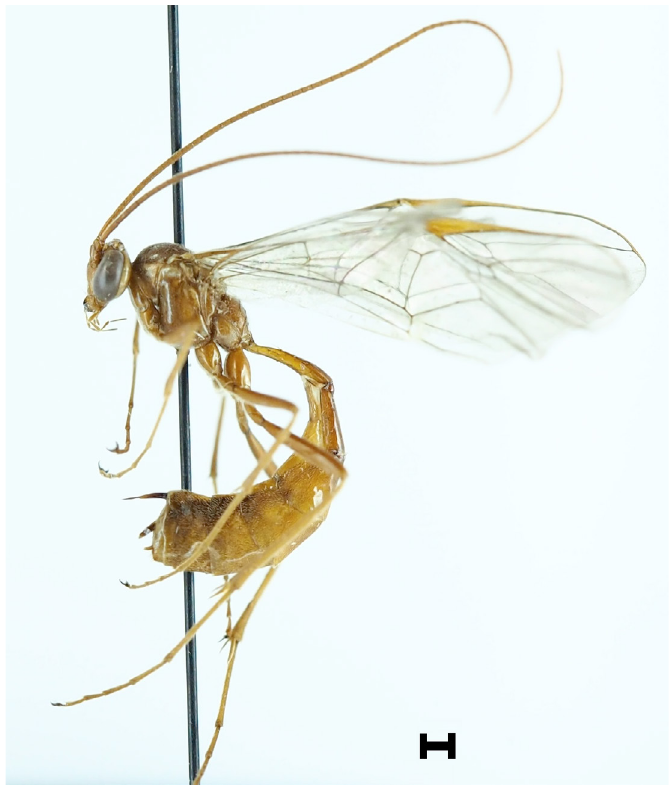
Fig. 38. Ophion paraparvulus Johansson sp. nov., paratype, ♀ (NHRS-HEVA000008696). Scale bar = 1